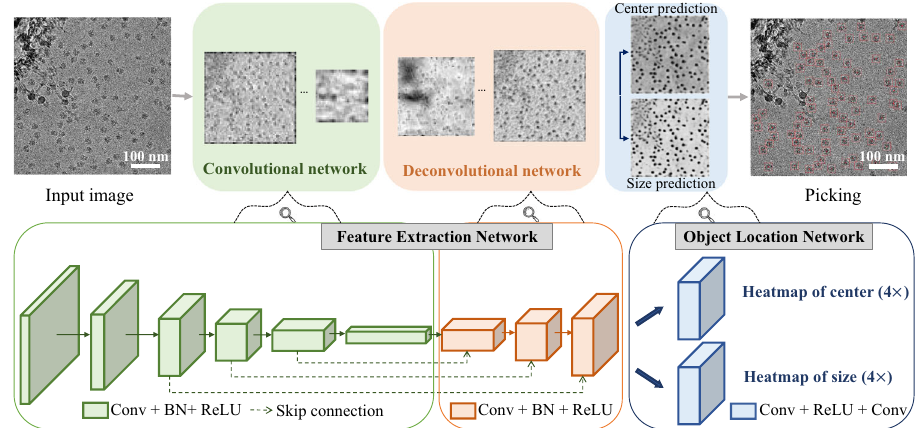
Fig. 2 Architecture of CenterNet detector in EPicker. The feature extraction sub-network is a cascade of a convolutional network (green) and a deconvolutional network (red) to extract features. Both the convolutional and the deconvolutional networks are a combination of Convolution-Batch Normalization 46 -ReLU(Recti fi ed Linear Unit) 47 blocks. The object location sub-network (blue) of the detector generates the heatmaps of particle center and size. The heatmap regression network is a combination of Convolution-ReLU-Convolution